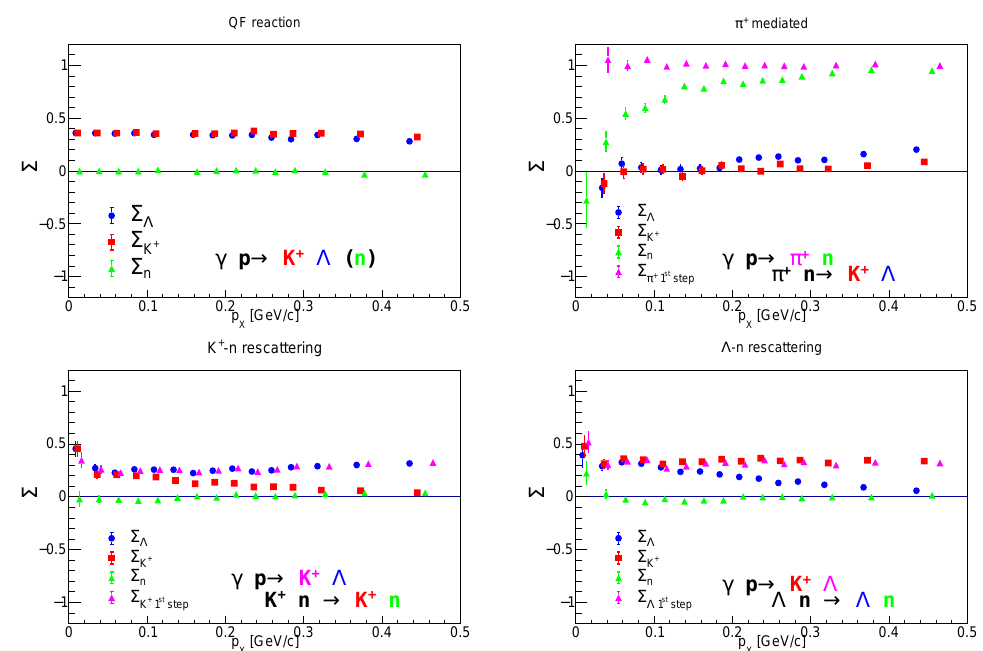
< x < 1 . 08 GeV/ c 2 . x